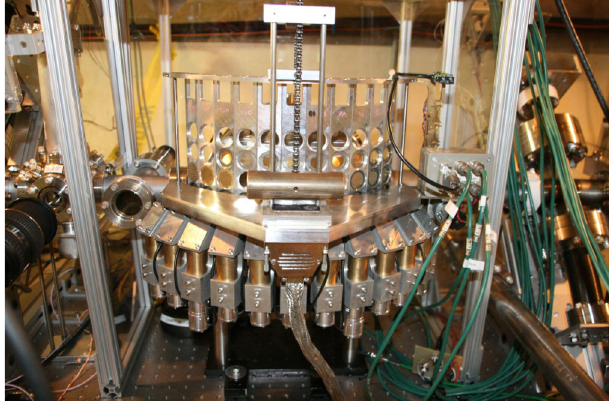
FIG. 3. The apparatus installed on the FACET beam line. Three of the filter rows are visible in the upper part of the filter ladder, together with the Winston cone-detector assemblies in the lower part of the